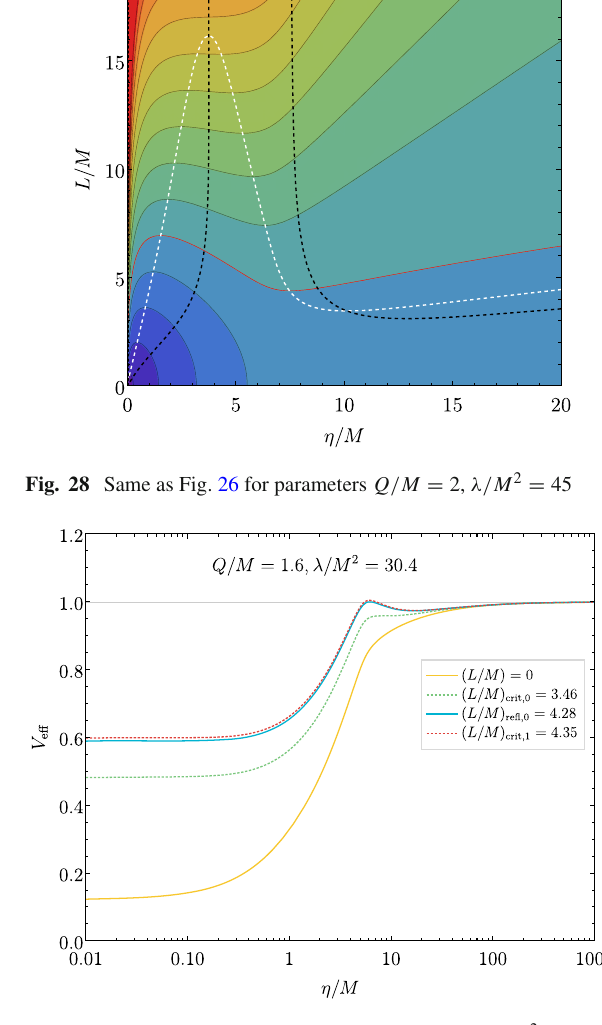
Fig. 29 Same as Fig. 25 for parameters Q / M = 1 . 6, λ/ M 2 = 30 .